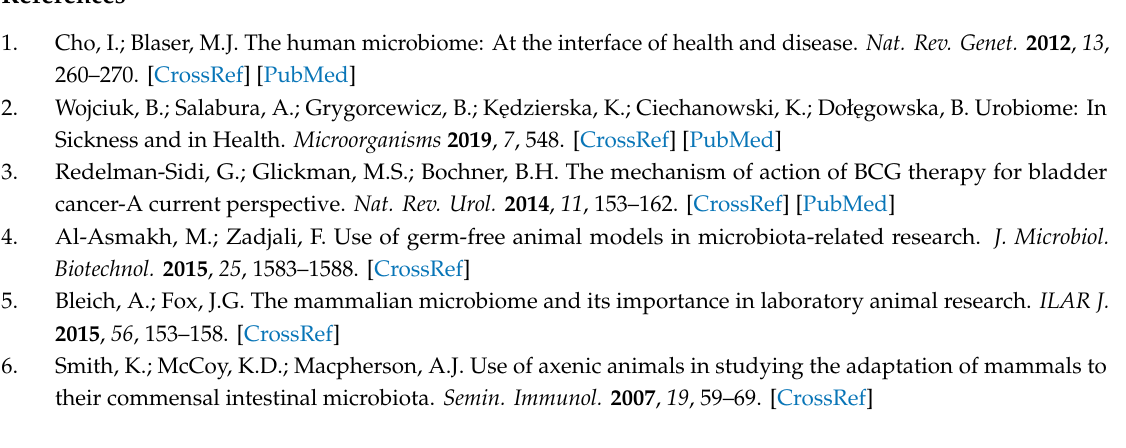
Figure S1: RNA-Seq sample comparison of GF and SPF groups, Figure S2: Concurrence of log 2 (fold change) from qPCR and RNA-seq analysis for 13 exemplar genes, Figure S3: KEGG pathways with significant change in gene expression, Figure S4: Log 2 (fold change (GF vs SPF)) of gene expression for A. gene markers for bladder cell types B. genes controlling muscle growth C. genes involved in bladder development, Table S1: Summary of mapping reads to mouse genome, Table S2: All di ff erentially expressed genes, Table S3: All KEGG pathways with significant changes in expression, Table S4: Enriched Molecular Functions in GF bladders, Table S5: Cellular components, reactome pathways and protein class enriched in GF tissue, Table S6: Shapiro-Wilk test for normal distribution, Table S7: Expression of genes for pattern recognition